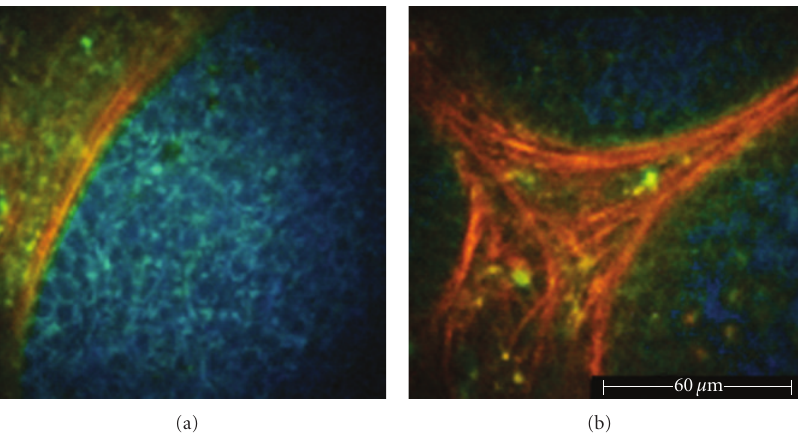
Figure 9: Basal cell carcinoma examined ex vivo . (a) 760 nm excitation wavelength. Nest of basaloid cells (blue) surrounded by a network of collagen fibers (red). (b) 800 nm excitation wavelength. Thick bundles of collagen fibers surrounding three basaloid